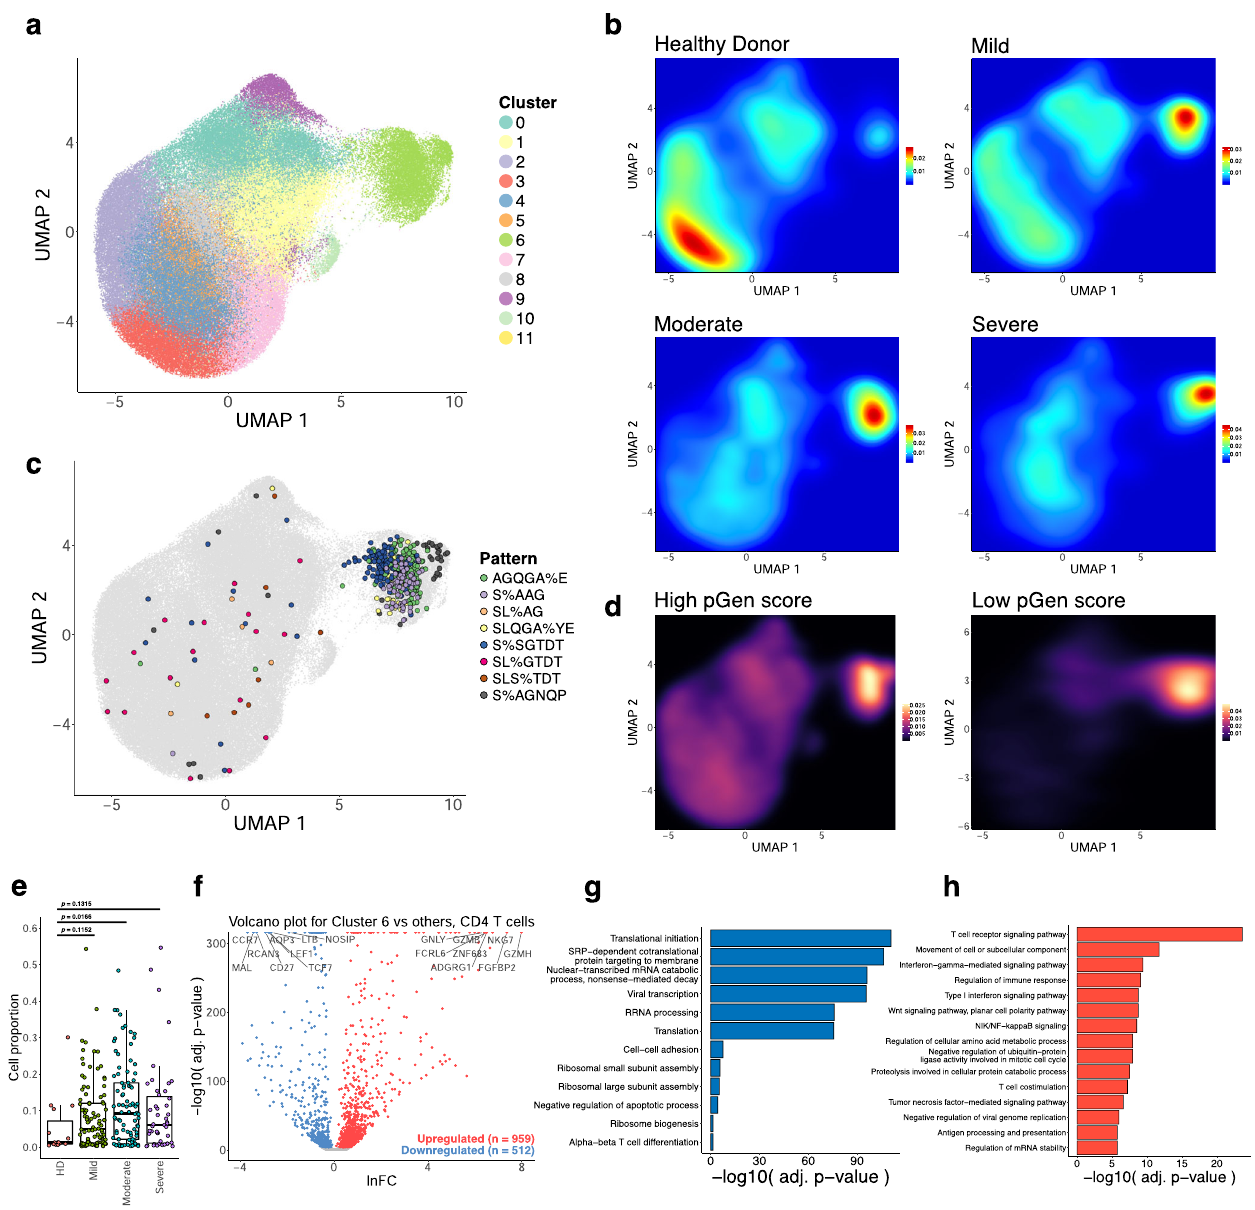
Fig. 3 Single-cell transcriptional signatures of clonal expansion of CD4 T cells. a UMAP visualization of 137,075 CD4 T cell single-cell transcriptomes from the ISB-S CD4 dataset pooled across samples and conditions. 12 clusters identi fi ed using the Louvain algorithm. b Two-dimensional density plot of cells from each disease condition (healthy donor, mild, moderate, severe) by UMAP coordinates. Red represents areas of high density of cells of a given condition; blue represents areas of low density. c UMAP visualization with cells labeled by top eight most frequent CD4 TCR clusters identi fi ed by the GLIPH2 analysis. d Two-dimensional density plot of cells with high or low pGen score clonotypes by UMAP coordinates. Yellow represents areas of high density of cells; black represents areas of low density. e Boxplots of clonally expanded cell proportions (in cluster 6) for each disease condition (cell count healthy donor = 544, mild = 3568, moderate = 5012, severe = 2336). Comparison between groups performed with two-sided Wilcoxon rank-sum test. f Volcano plot of differentially expressed genes between clonally expanded cells and all other cells in the ISB-S CD4 dataset (Cluster 6 cells = 5000, all other cells = 5000). Differential gene expression was performed with Seurat using the two-sided Wilcoxon rank-sum test; the Bonferroni corrected adjusted p -values and log fold-change of the average expression were used for visualization. g Bar plot of biological processes (BP) pathway terms associated with downregulated genes (clonally expanded cells vs all other cells, q -value < 1e-4) by DAVID analysis. h Bar plot of biological processes (BP) pathway terms associated with upregulated genes (clonally expanded cells vs all other cells, q -value < 1e-4) by DAVID